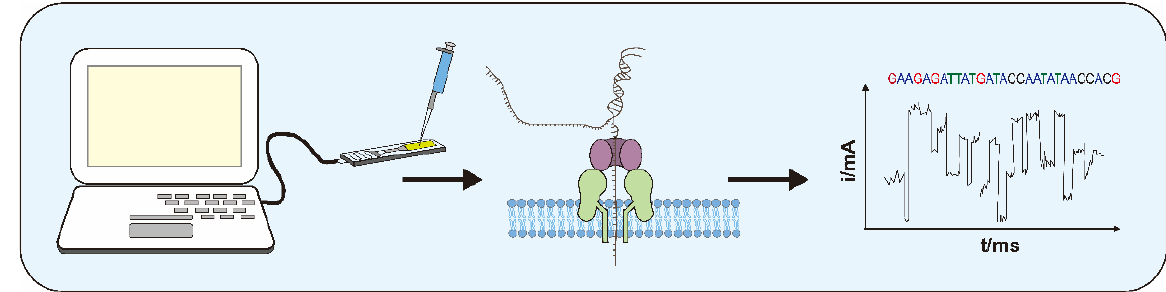
Figure 1. Schematic representation of the principle and process of nanopore sequencing.